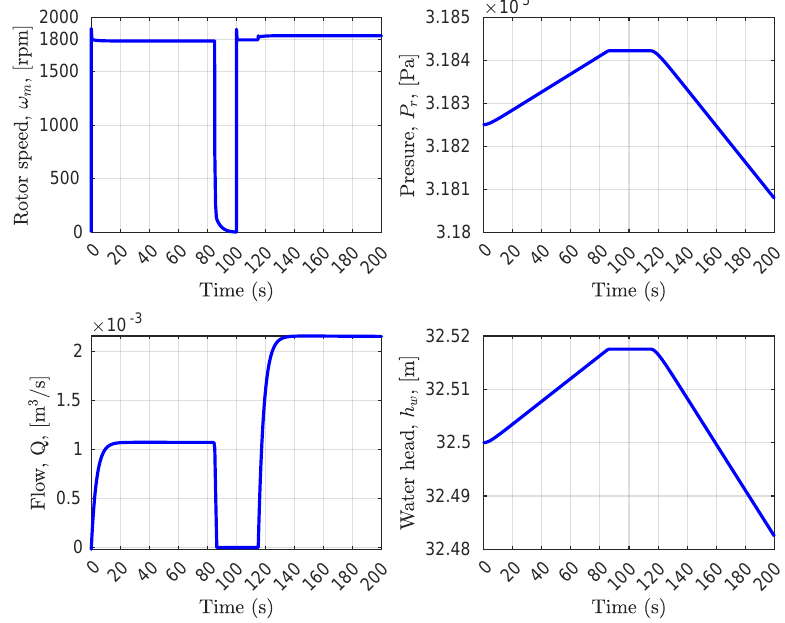
Figure 5. Third scenario: operation of the reversible hydropump–turbine system with s = 0 at t 85 ( s ) , and s = 1 at t 100 ( s ) . Both hydraulic and electromechanical systems are switched off ≤ ≥ between 85 < t < 100 ( s ) . The asynchronous machine and the hydraulic system are switched on at t = 100 ( s ) and t = 115 ( s ) , respectively. The initial conditions are Q ( 0 ) = 0.0 ( m 3 / s ) , P r ( 0 ) = 3.1825 10 5 ( Pa ) , and h w = 32.5 ( m ) ×